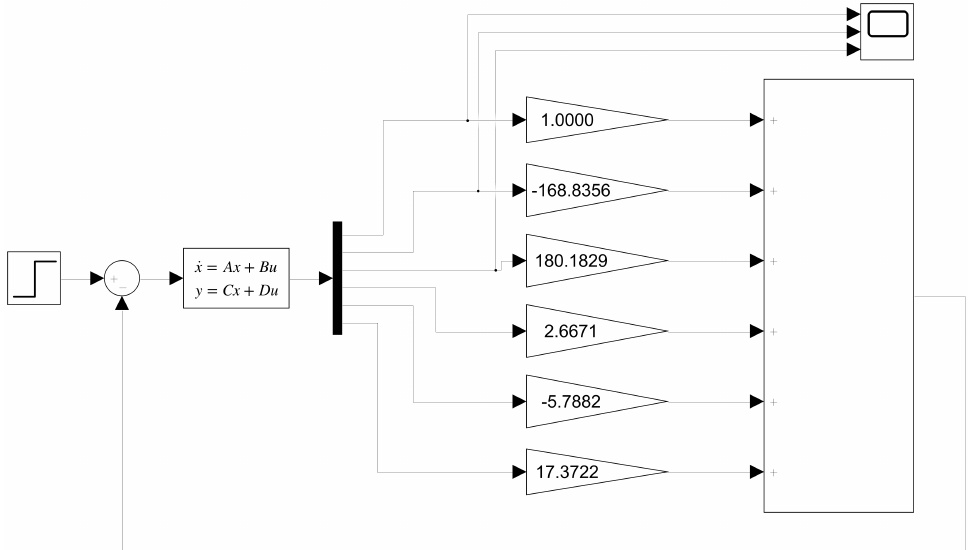
Figure 8. Simulink model of the LQR